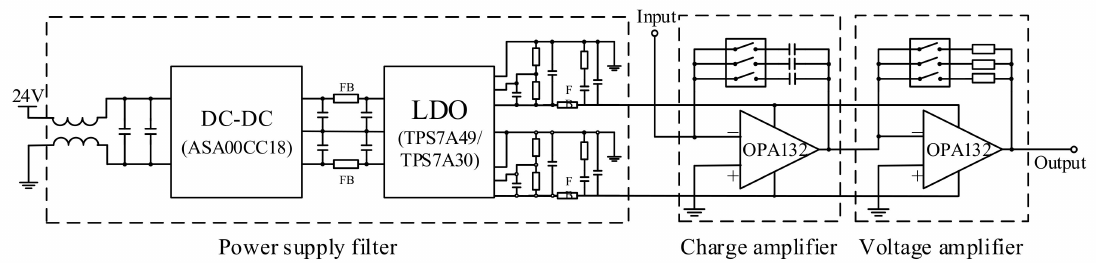
Figure 7. Schematic diagram of the charge amplifier.